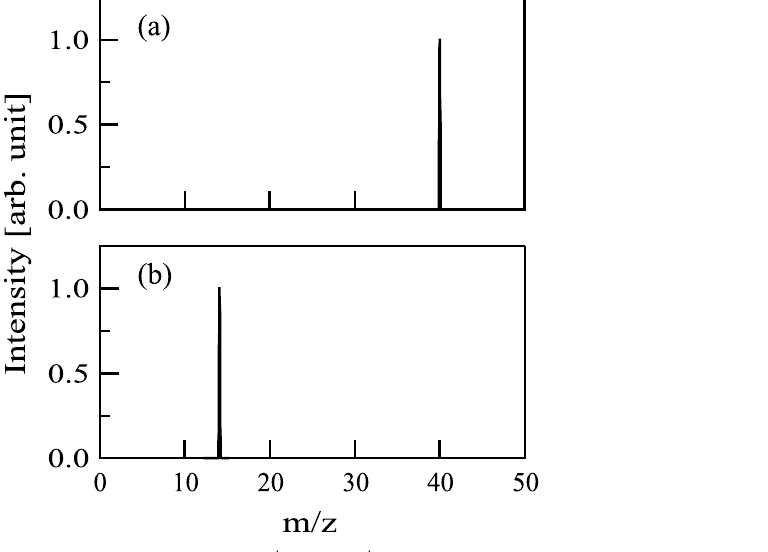
Fig 2. The mass spectra of (a) Ar + and (b) N + ion